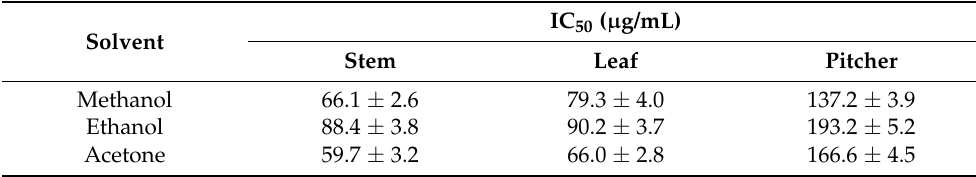
Figure 1. Antioxidant activity of different extracts of N. miranda . The antioxidant activities of extracts from stems, leaves, and pitchers prepared using ( A ) methanol, ( B ) ethanol, and ( C ) acetone were evaluated by DPPH radical scavenging assay. evaluated by DPPH radical scavenging assay. Table 1. Antioxidant activities of N. miranda